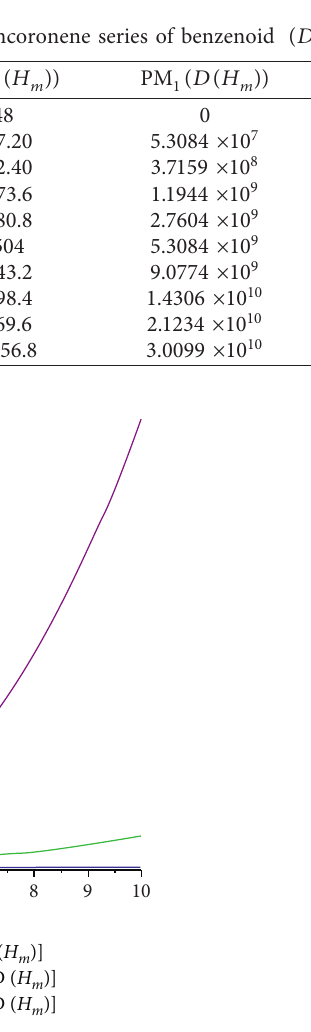
Figure 4: Graphical representation of topological indices of double graph of circumcoronene series of benzenoid ( H